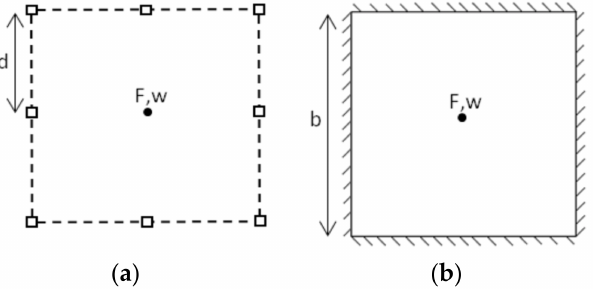
Figure 4. Model of continuous micromirror array with a concentrated load in the middle. ( a ) A square plate fixed by pillars. ( b ) A square plate clamped by peripheral